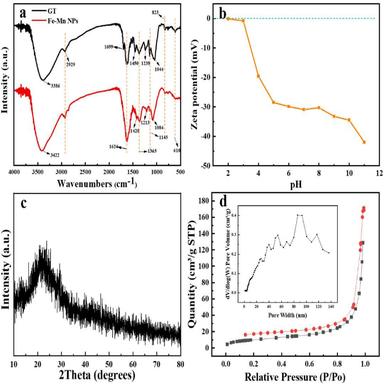
FTIR spectra of green tea extract (a, black line) and Fe–Mn NPs (a, red line); pH dependance of the zeta potential of optimized Fe–Mn NPs (b); XRD pattern of Fe–Mn NPs (c); the BET nitrogen adsorption-desorption isotherm and corresponding pore size distribution of Fe–Mn NPs (d).